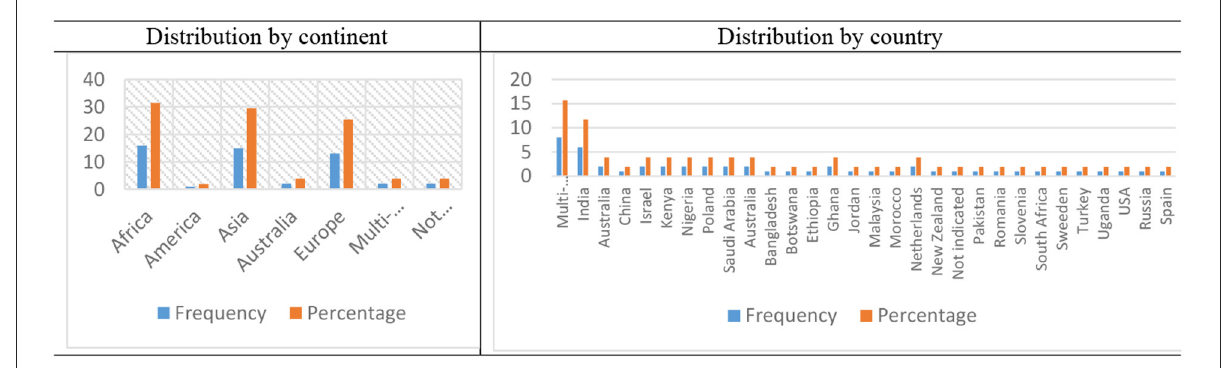
FIGURE3 Distribution of the articles by region.